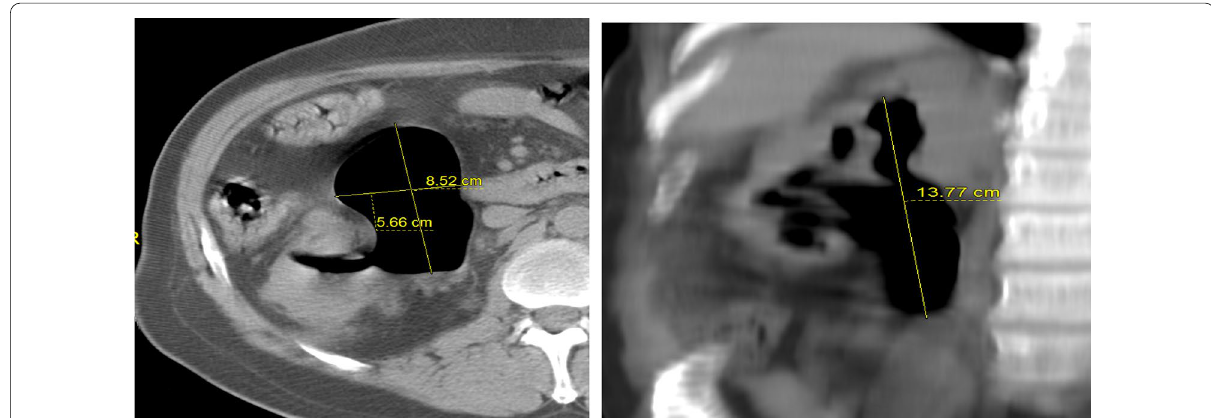
Fig. 2 A 66‑years old diabetic female patient presented with high grade fever and right loin pain. CT axial and coronal images demonstrate hydronephrotic changes with gas accumulated in the right pelvicalyceal system, it measures 8.5 cranio‑caudal dimensions with total air locules volume 327 cc. the patient was managed unsuccessfully by medical treatment, and drainage was done by ureteric